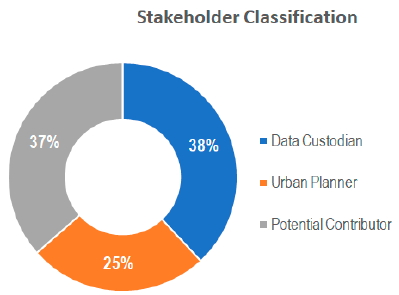
Figure 8. Respondents based on actor role derived from their affiliation .